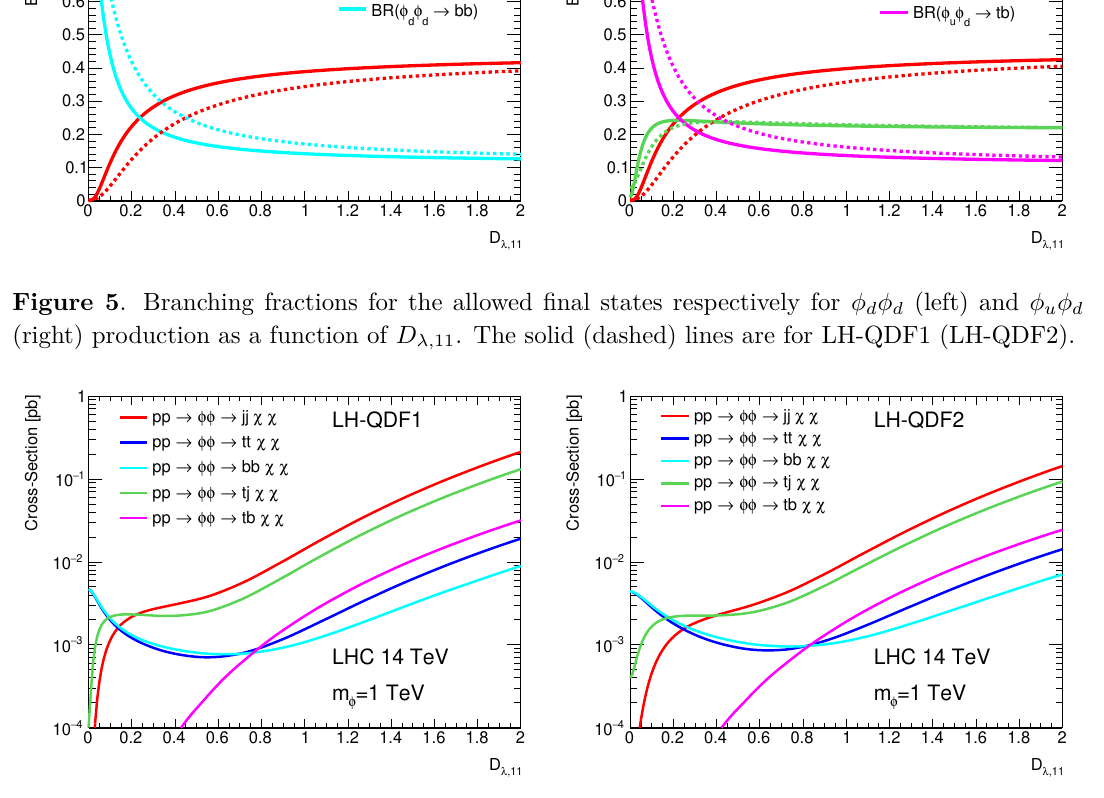
. Left: LH-QDF1, λ, 11